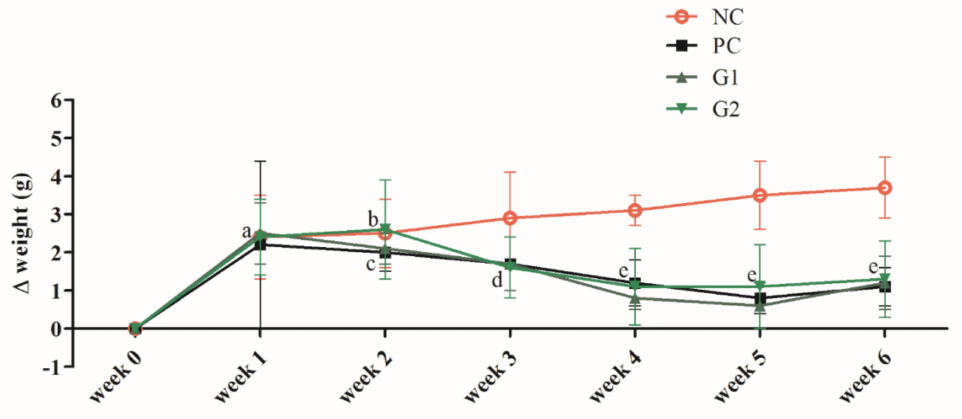
Figure 5. Time course of weight changes ( ∆ weight) after oral administration of physiological saline, 50 mg/kg, and 100 mg/kg body weight of P-SPI. Each data point represents mean ± SEM from 5 determinations, and data points with the different alphabets are significantly different ( p < 0.05) using one-way ANOVA followed by Duncan tests. NC: Negative control, PC: Positive control, G1: Group 1, G2: Group 2.